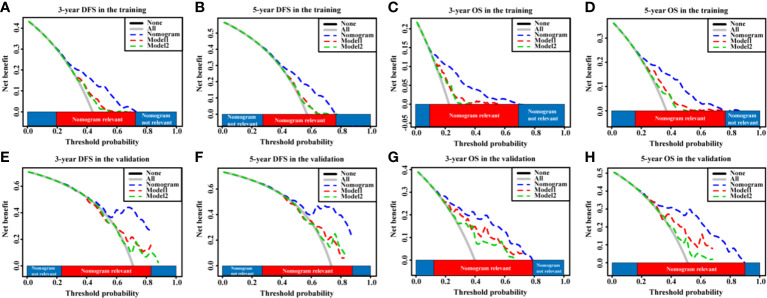
The DCA curves of the nomogram models and other models in HCC patients. (A–D) DCA curves showing the clinical utility of the nomogram models other models for the 3-year DFS (A) and OS (C) rates and 5-year DFS (B) and OS (D) rates in the training cohort. (E–H) DCA curves showing the clinical utility of the nomogram models and other models for the 3-year DFS (E) and OS (G) rates and 5-year DFS (F) and OS (H) rates in the validation cohort. GPR, gamma‐glutamyl transpeptidase‐to‐platelet ratio; ALB, albumin; DCA, decision curves analysis; HCC, hepatocellular carcinoma; DFS, disease-free survival; OS, overall survival.